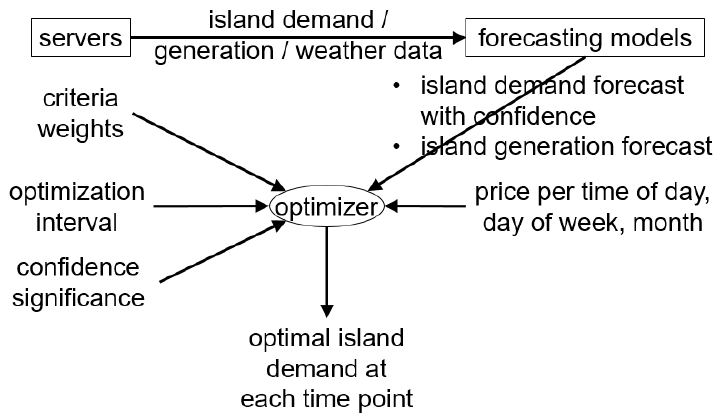
Figure 9. Low-level architecture of the optimization algorithm and relation with the forecasting